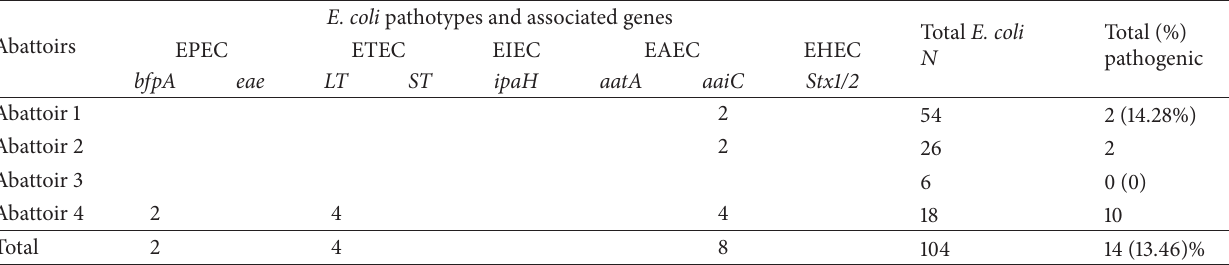
Table 4: Prevalence of pathogenic E. coli from the various abattoirs. Abattoirs